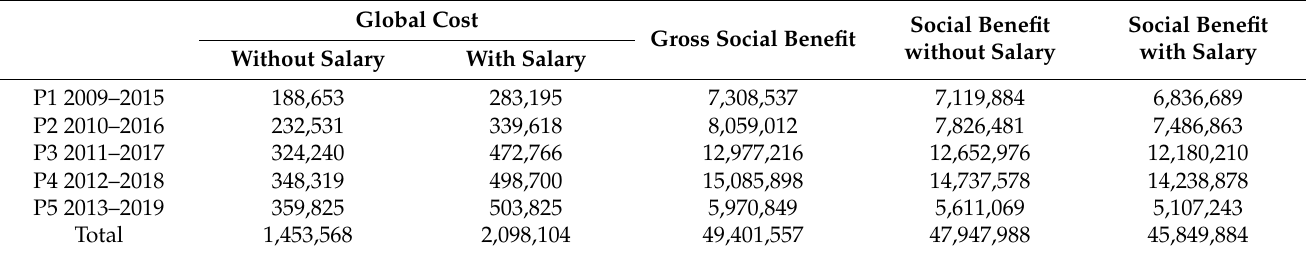
Table 5. Social benefit per class of graduates (EUR, 2019 prices). Global Cost